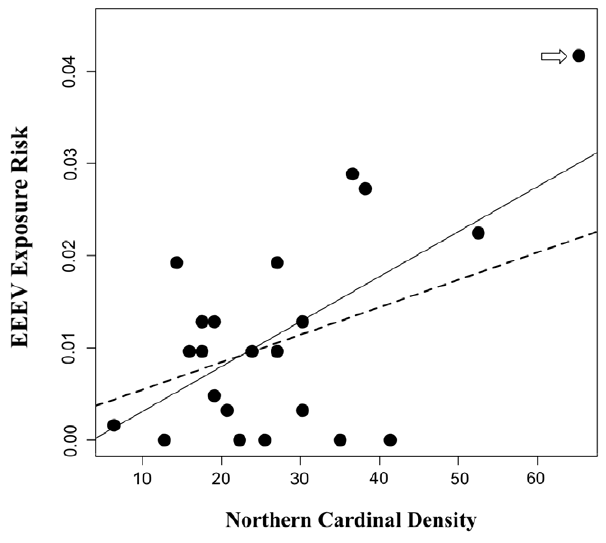
Figure 3. Association between EEEV exposure and northern cardinal density. Scatterplot showing the relationship between EEEV exposure risk in chickens during 2009 and 2010 and northern cardinal density at 24 sentinel sites in Walton County, Florida. The estimate for the slope of exposure risk regressed on northern cardinal density was 0.006 with a 95% UCI of [0.0025, 0.0107]. This estimated slope, when an influential observation (indicated by the arrow) was removed from the dataset, was 0.004 [ 2 0.001, 0.009]. The best-fit line from simple linear regression of exposure risk residuals on northern cardinal density are overlaid, with the solid line fit to the full dataset, and the dashed line fit to the dataset that excluded the influential observation.